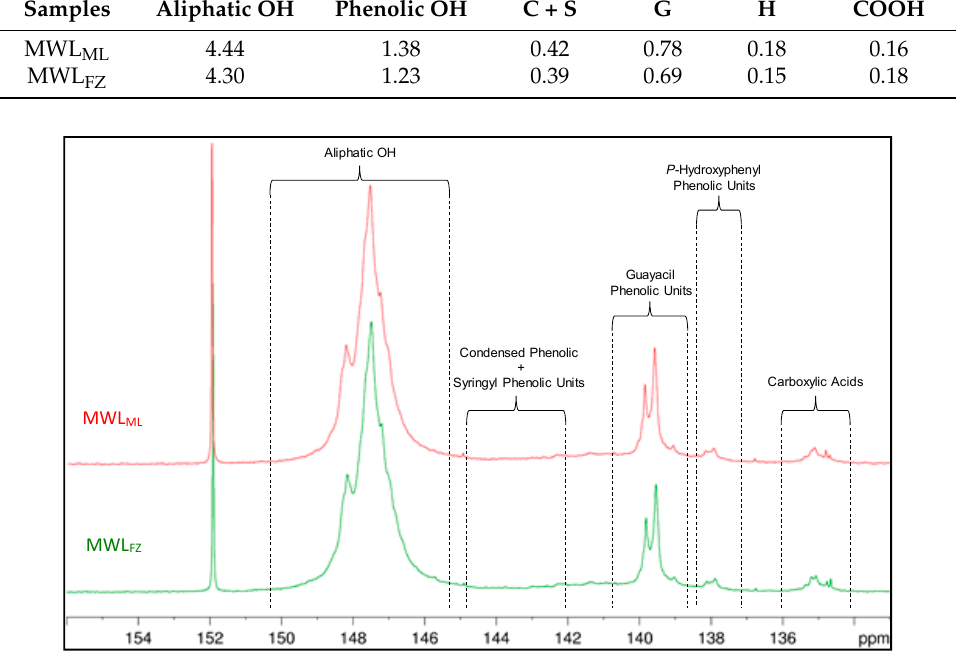
Table 5. Compositional analysis from 31 P NMR spectra of MWLs (mmol/g).